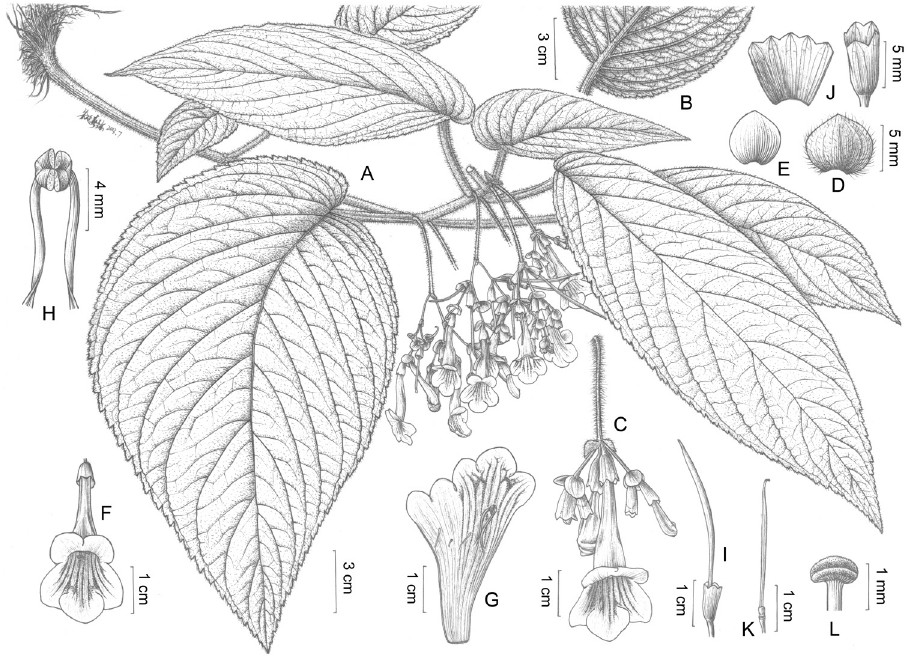
Figure 6. Didymocarpus brevipedunculatus Y.H.Tan, sp. nov. A Habit B leaf base in abaxial view C inflorescence D bract in abaxial view E bracteole F flower in front view G dissected corolla H stamens I young capsule J calyx K pistil L stigma. Drawn by Yun-xi Zhu.